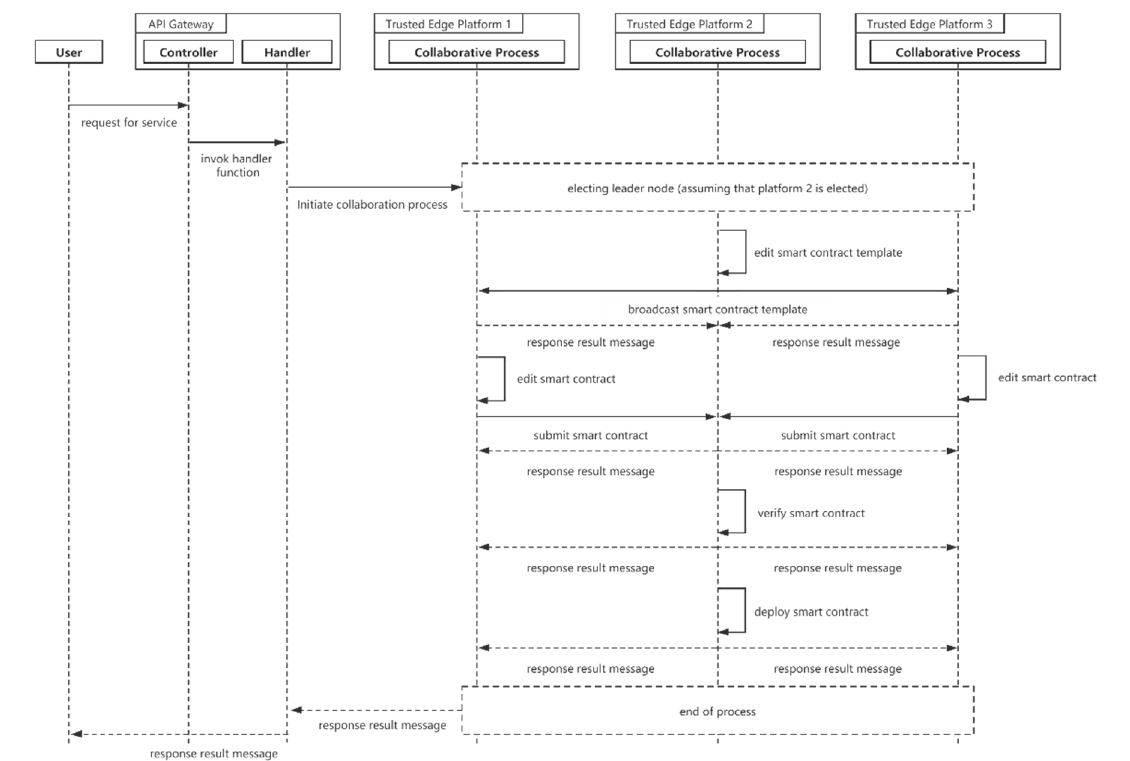
Figure 7. Sequence diagram for the collaborative process.